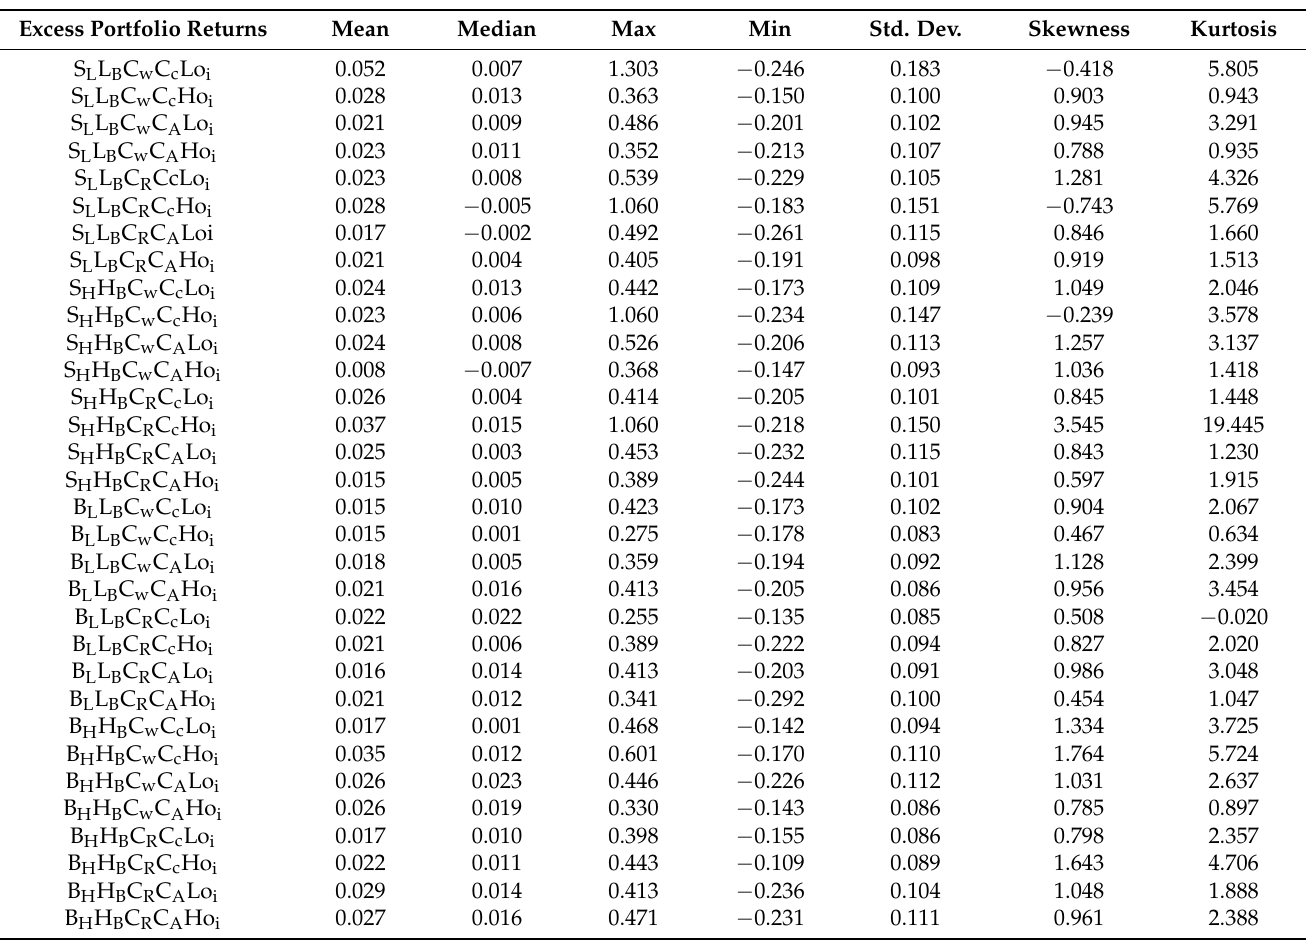
Table 1. Descriptive summary of the thirty-two